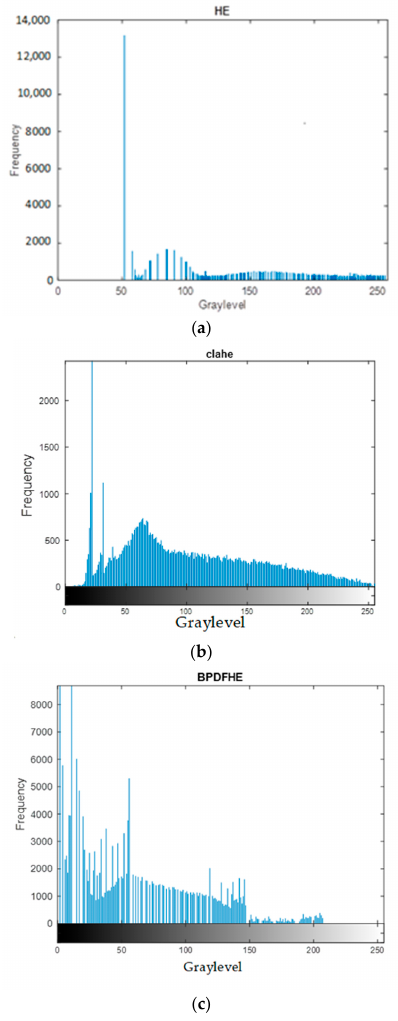
Figure 9. Histograms of preprocessed images of Figure 8. ( a ) HE, ( b ) CLAHE, and ( c ) BPDFHE.